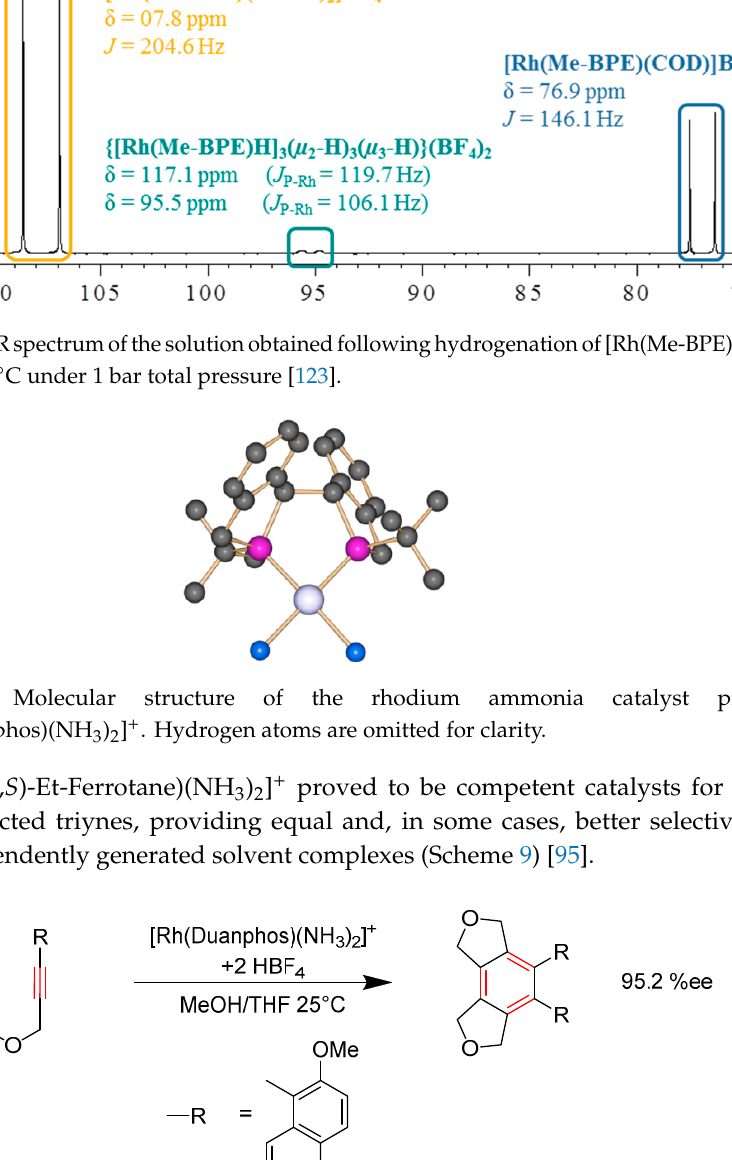
Figure 11. 31 P NMR spectrum of the solution obtained following hydrogenation of [Rh(Me- BPE)(COD)] + in MeOH- d 4 at 25 °C under 1 bar total pressure [123].